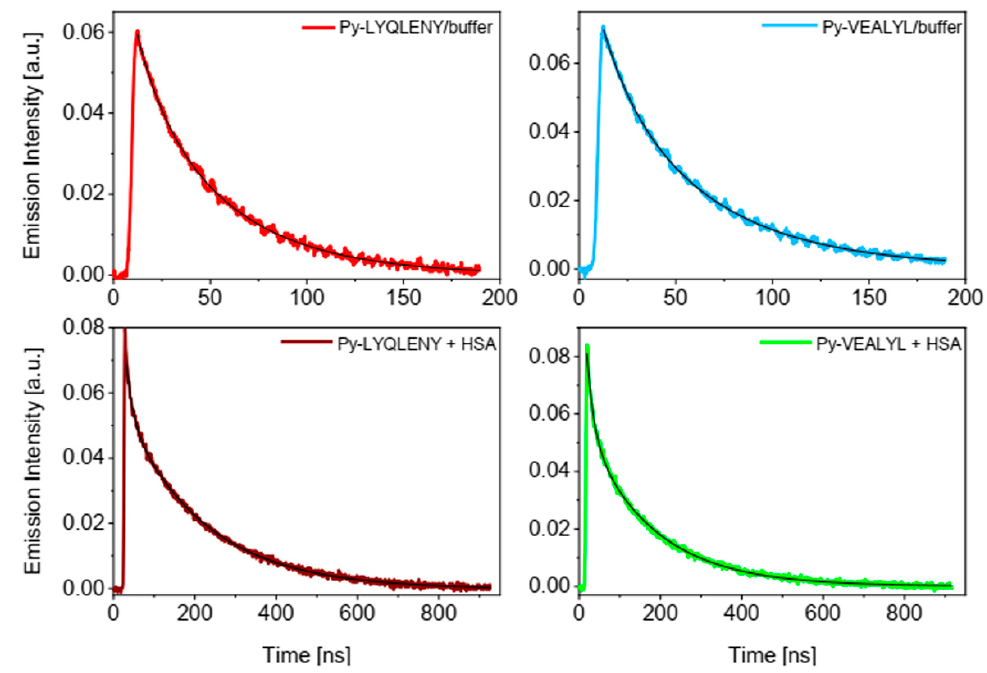
Figure 7. Time profiles of Py-LYQLENY ( 2 ) and Py-VEALYL ( 3 ) fluorescence decay in buffer and in the presence of HSA. Smooth lines represent best-fits to experimental curves. [HSA] = 30 µM, λ exc = 337 nm, λ em = 400 nm. Table 2. Lifetimes of Py-LYQLENY ( 2 ) and Py-VEALYL ( 3 ) fluorescence decay in PBS and in the presence of HSA according to mono- and bi-exponential kinetics, respectively.